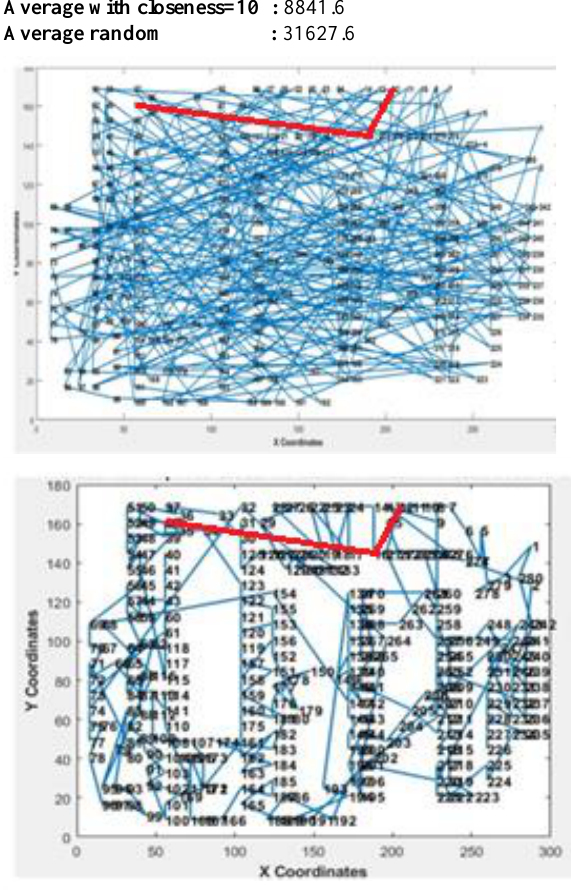
Fig 9. A280 path after iteration number 1: With random choice, with closeness parameters at